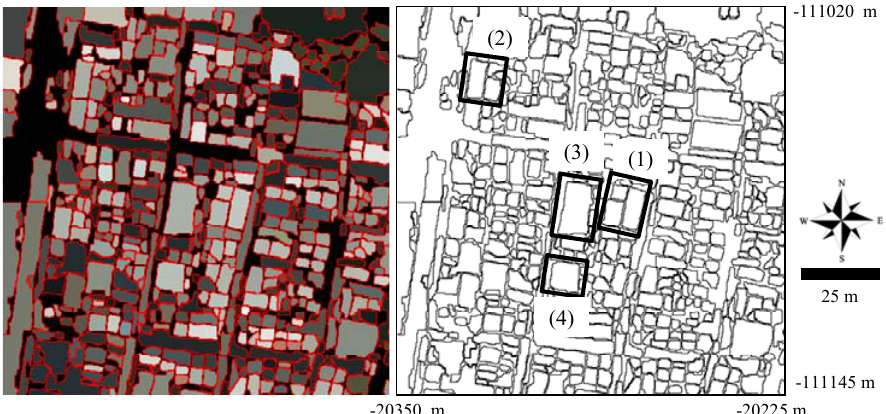
Figure 9. Segmentation result for Figure 8 by the algorithm proposed in